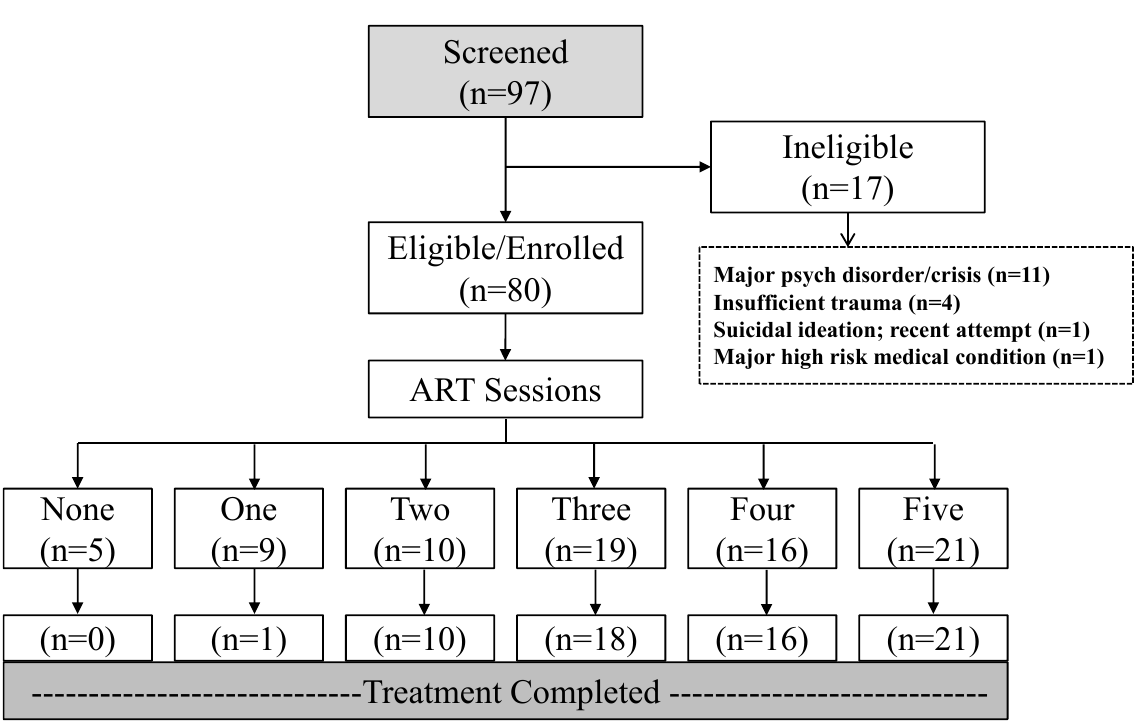
Figure 1 . Flow diagram of screening, enrollment, and treatment completion of study